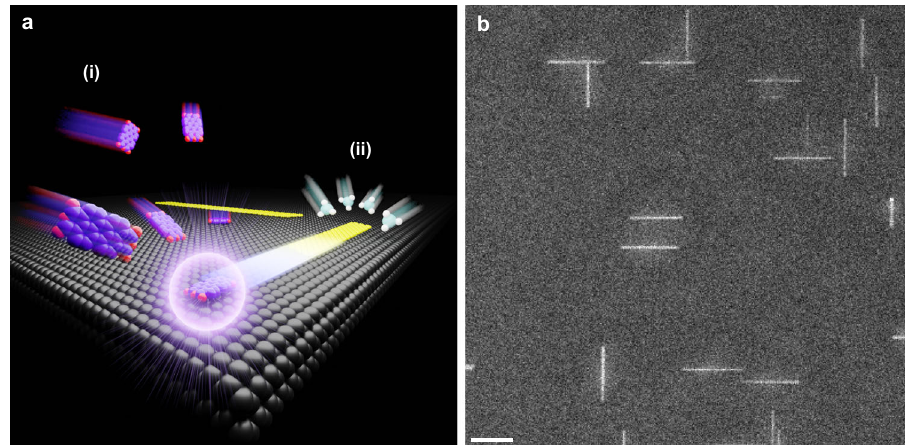
Fig. 1 Nanoribbon synthesis from molecularly derived seeds. a Schematic diagram of the two main stages. (i) PAH molecules (red = oxygen and purple = carbon) are deposited at relatively low temperature onto Ge(001) (gray) from the vapor phase to form seeds. (ii) CH 4 (light blue = carbon and white = hydrogen) is used to drive anisotropic growth via CVD and extend the seeds selectively along one direction, at high temperature, to yield narrow, armchair graphene nanoribbons. b Representative SEM image of nanoribbons initiated from PTCDA-derived seeds after 173 min of CH 4 exposure. Scale bar is 200